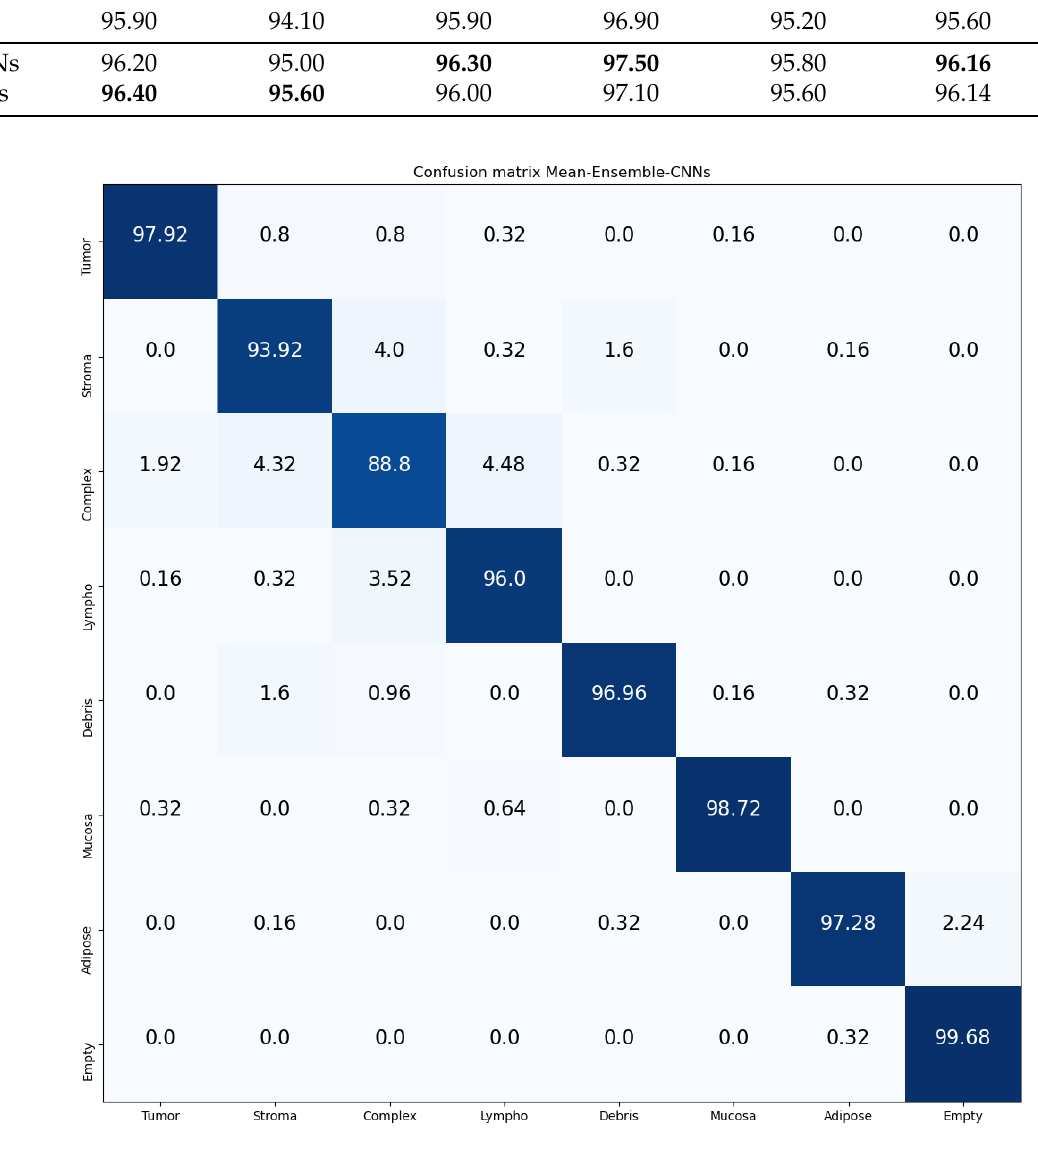
Figure 14. Confusion Matrix of our proposed approach: Mean-Ensemble-CNNs on Kather-CRC-2016 database. The vertical axis is for the true classes and the horizontal axis is for the predicted